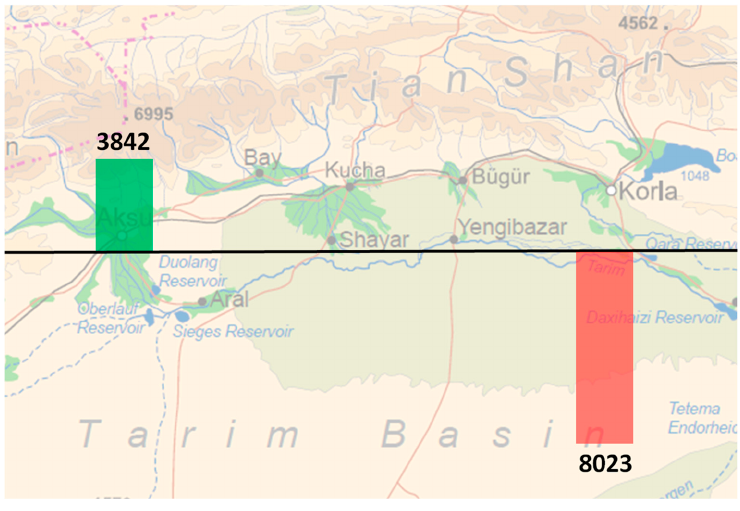
Figure 5. Forest gain at Aksu and consequent forest loss at the Tarim River’s middle and lower reaches, in hectares.